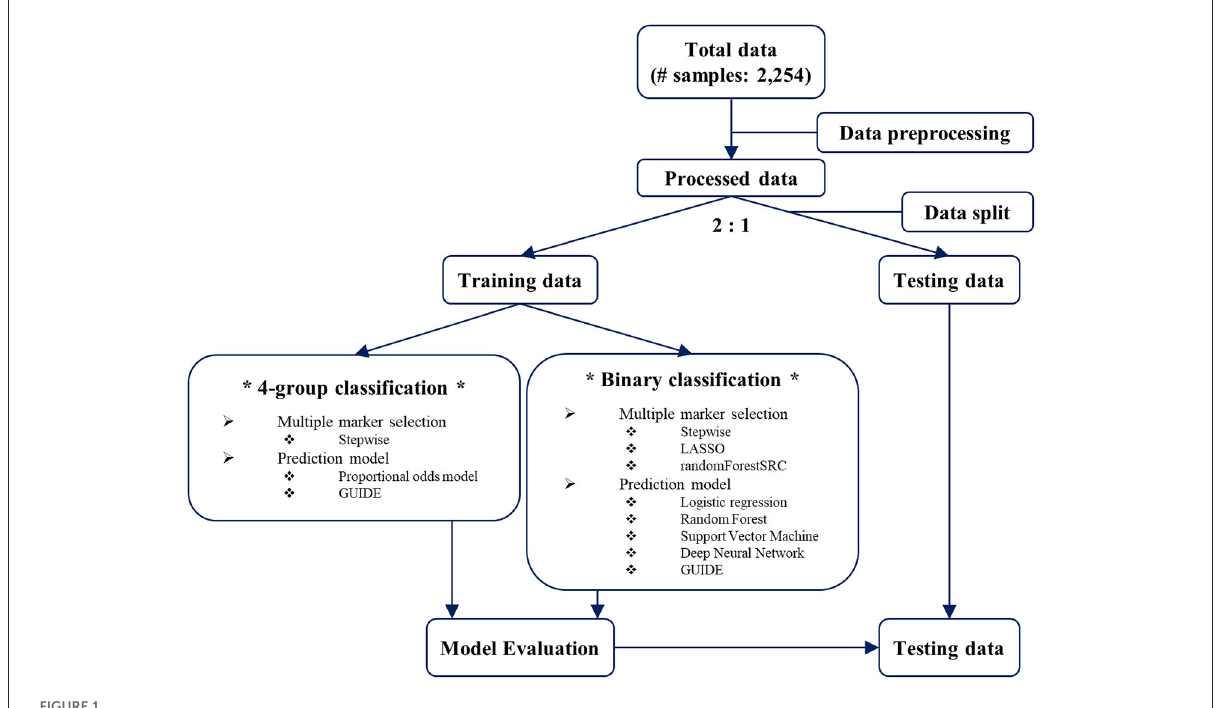
FIGURE1 The overall workflow for predictive model development.